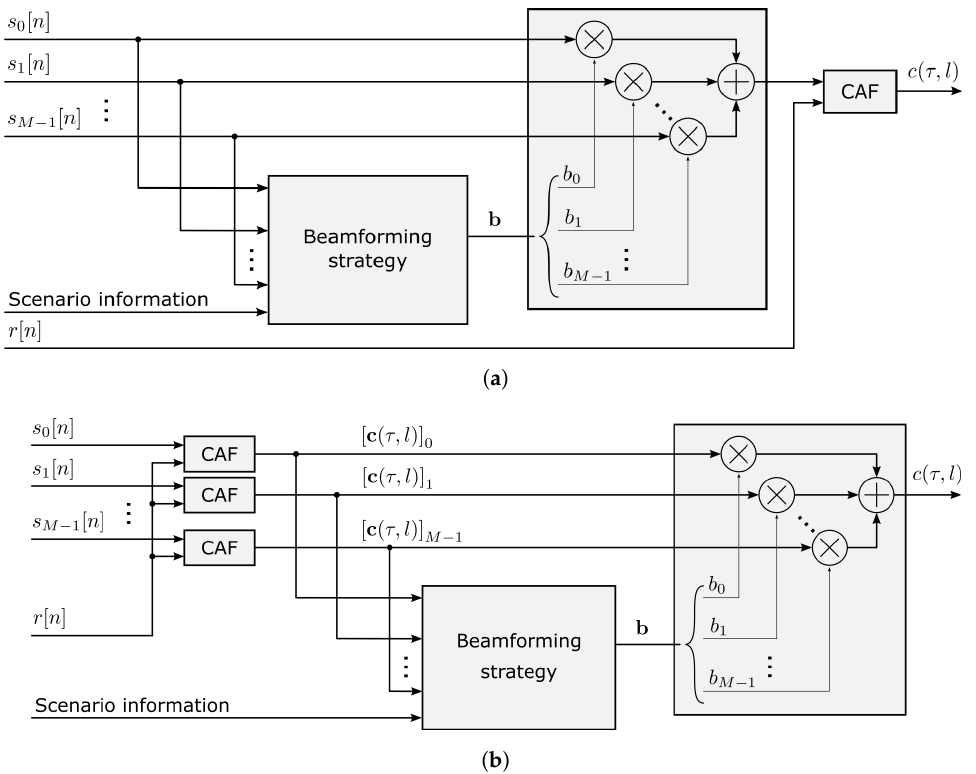
Figure 3. Comparison of main beamforming techniques, applied in different domains: ( a ) in the angular domain, before the CAF; ( b ) in the range–Doppler domain, after the